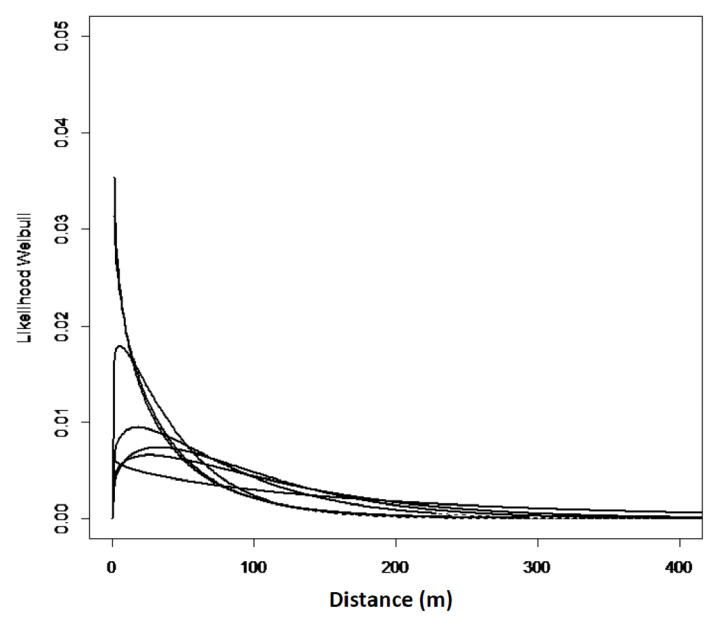
Figure 3. Expected Weibull distribution for the seven sites in west Norway, Model No. 1.